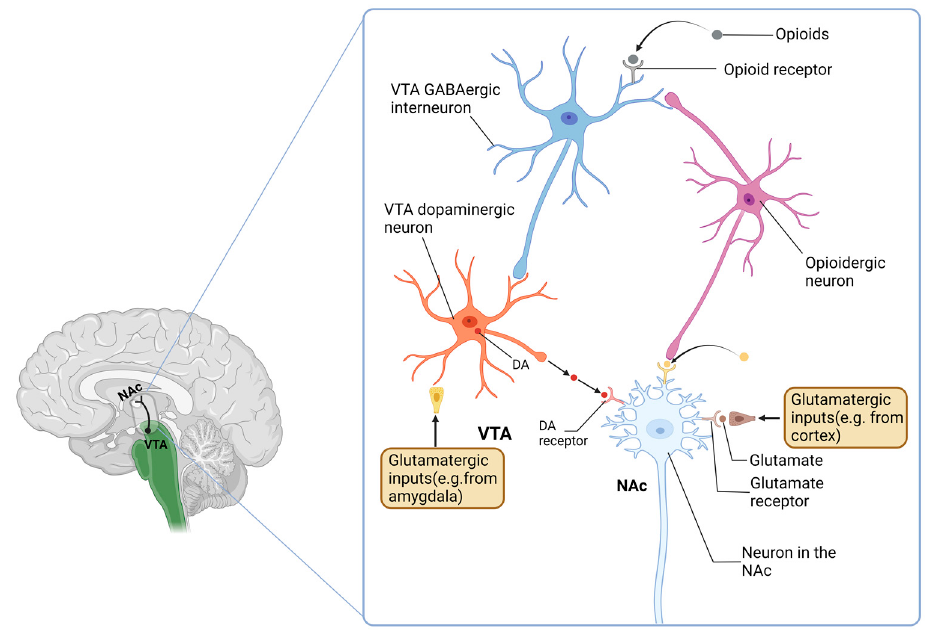
Figure 3. Rewarding actions of opioids in the VTA and NAc. Drug abuse, especially opioid abuse, has some significant effects on the area of VTA and NAc. γ -aminobutyric acid (GABA)ergic interneurons in the VTA are inhibited by opioids mainly via µ-opioid receptors but also by δ -opioid receptors. This leads to the disinhibition of VTA dopaminergic neurons and activation of reward circuitry in the Nac. Furthermore, reward circuitry is also activated directly by opioids through opioid receptors on NAc neurons. VTA: ventral tegmental area; NAc: nucleus accumbens.